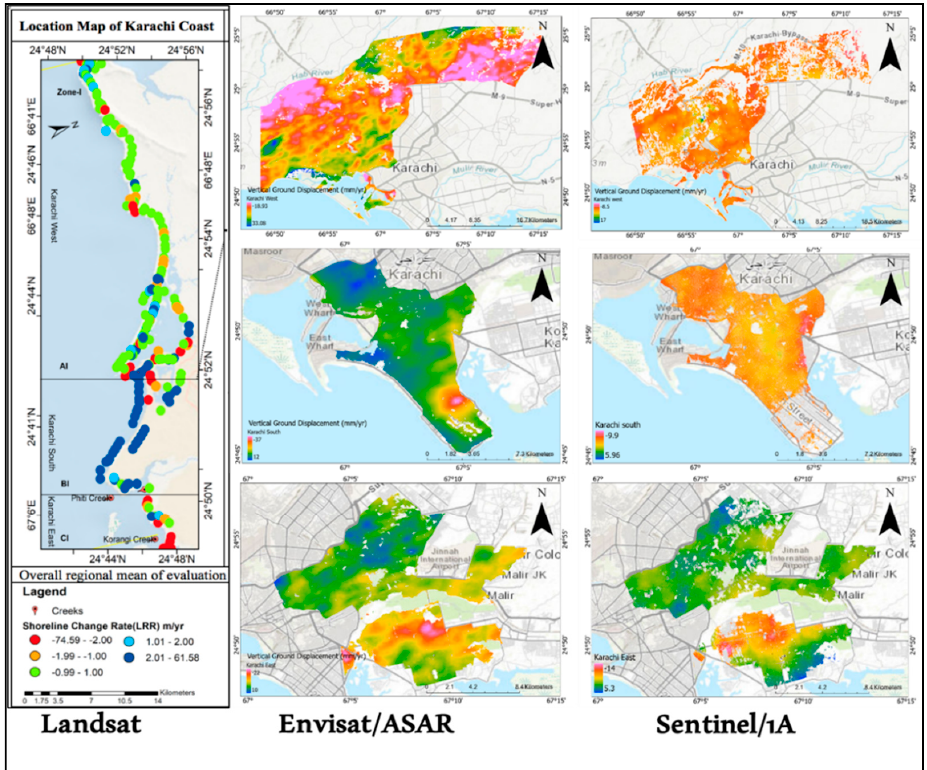
Figure 8. Karachi coastline change rates estimated by the LRR method using USGS DSAS for the period 1989–2018 ( left ). The zone-wise map shows the regional distribution of mean vertical ground displacement in the coastal zones ( middle and right ). These distribution maps show an expansion in extent between subsidence and uplifting over the time in the study area from 2004 to 2016 with substantial subsidence in the DHA, Korangi, and Landhi areas.